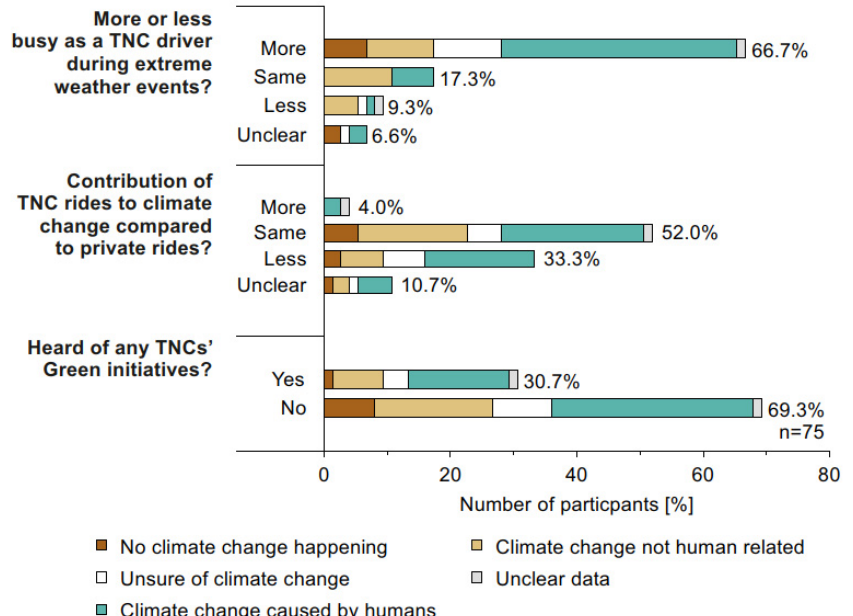
Figure 4. Participants driving for TNCs’ (Transportation Network Company) opinions on how extreme weather affects their TNC business ( top panel ), how TNC rides affect the climate differently than driving private cars ( middle panel ), and the number of participants that have heard of any TNCs’ green initiatives ( bottom panel ). All responses were categorized by participants’ climate change belief categories according to Figure 1.